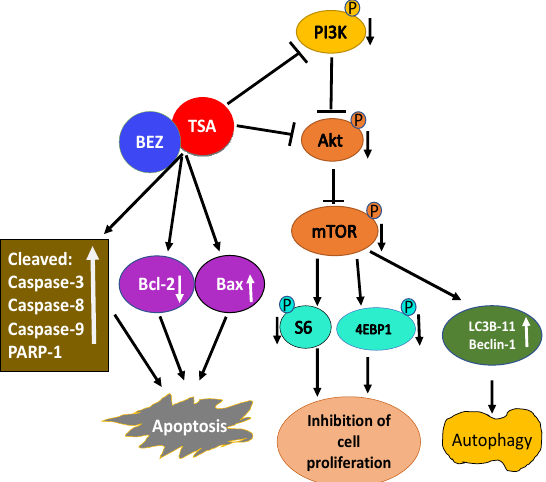
Figure 3. Schematic illustration of activity of TSA/BEZ235 combination on breast cancer cells. Combination treatment of TSA/BEZ235 results in synergistic suppression of breast cancer cells [152]. Through reduced activation of PI3K/Akt/mTOR and their downstream targets, TSA/BEZ235 drug combination accounts for inhibition of cell proliferation and apoptosis. The anti-breast cancer effect of drug combination is through both the mitochondrial and the death receptor pathway. TSA/BEZ235 combination also causes autophagy. (blunt end lines indicate inhibition, upward arrows indicate upregulation and downward arrows indicate downregulation of proteins).